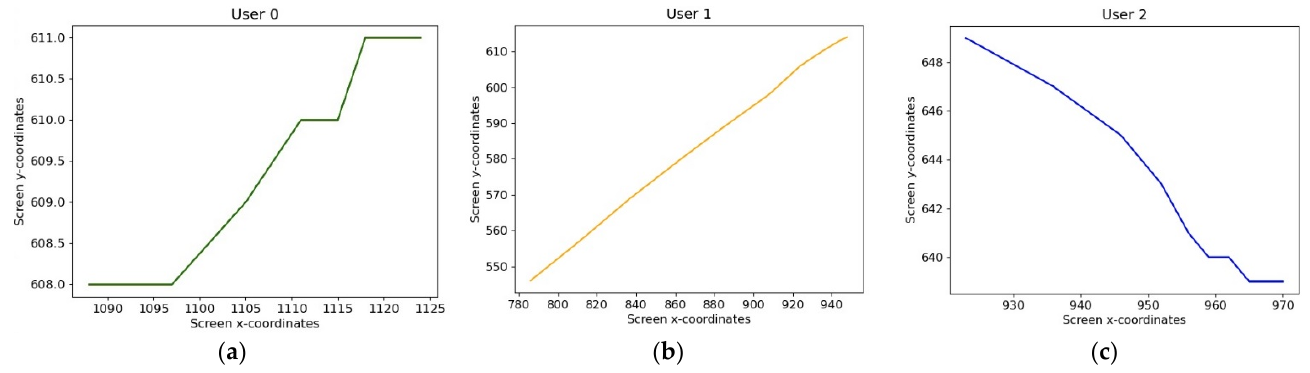
Figure 2. ( a ) Visual representation of one of user 0’s mouse action with block length 10; ( b ) visual representation of one of user 1’s mouse action with block length 10; and ( c ) visual representation of one of user 2’s mouse action with block length 10.